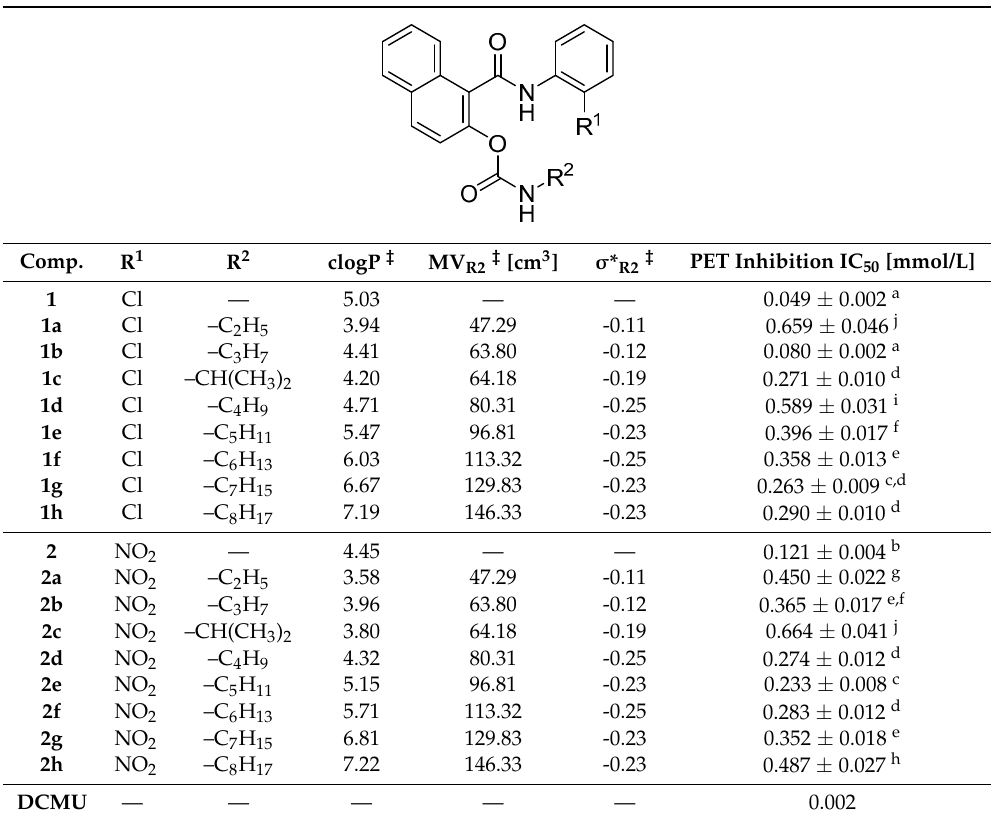
Table 1. Structures of the discussed anilides 1 , 2 and carbamates 1a – 1h , 2a – 2h ; predicted clogP values, molar volume MV [cm − 3 ], Taft polar constants σ * of R 2 substituents of compounds and IC 50 [mmol/L] values related to PET inhibition in spinach chloroplasts of tested compounds in comparison with 3-(3,4-dichlorophenyl)-1,1-dimethylurea (DCMU) standard. IC 50 values